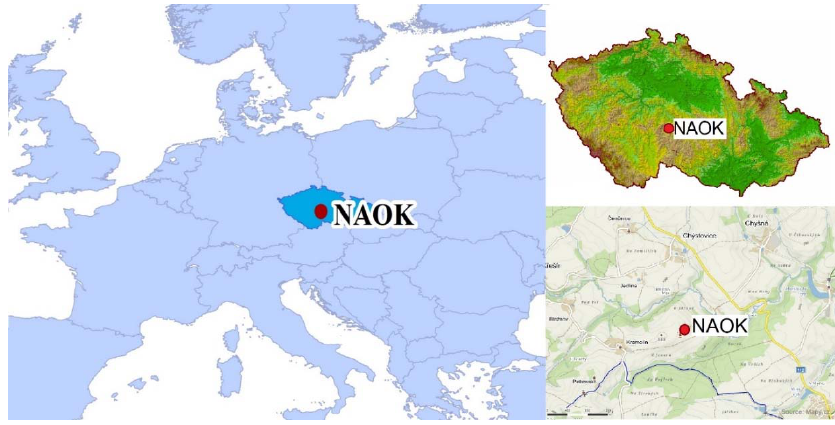
Figure 1. Location of National Atmospheric Observatory Košetice (NAOK) in the European, Czech and local context.